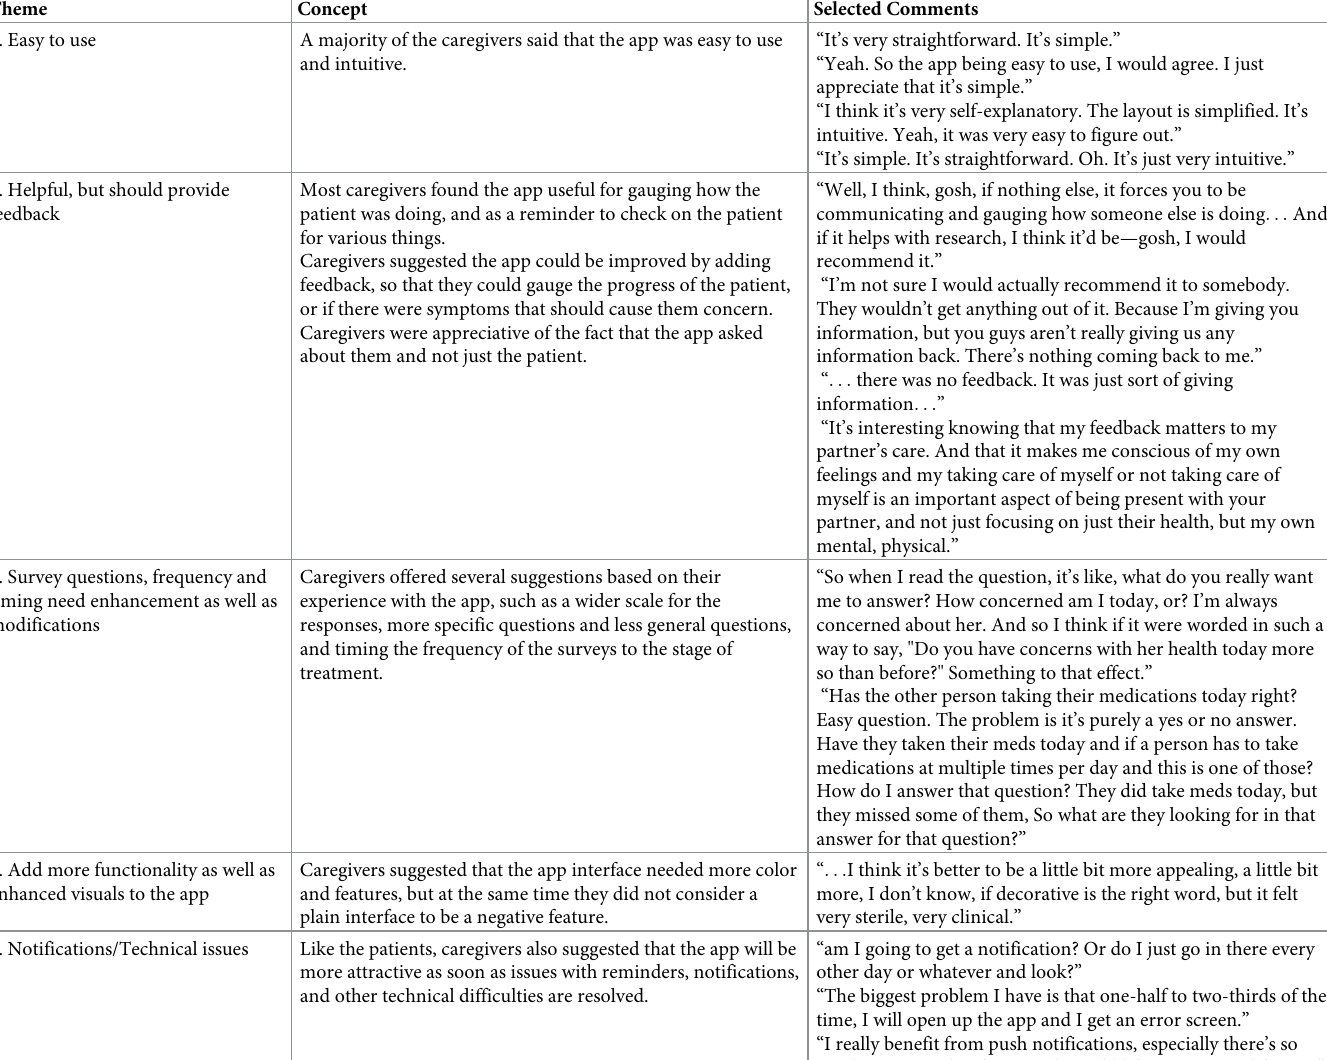
Table 4. TOGETHERCare app: qualitative analysis themes with illustrative